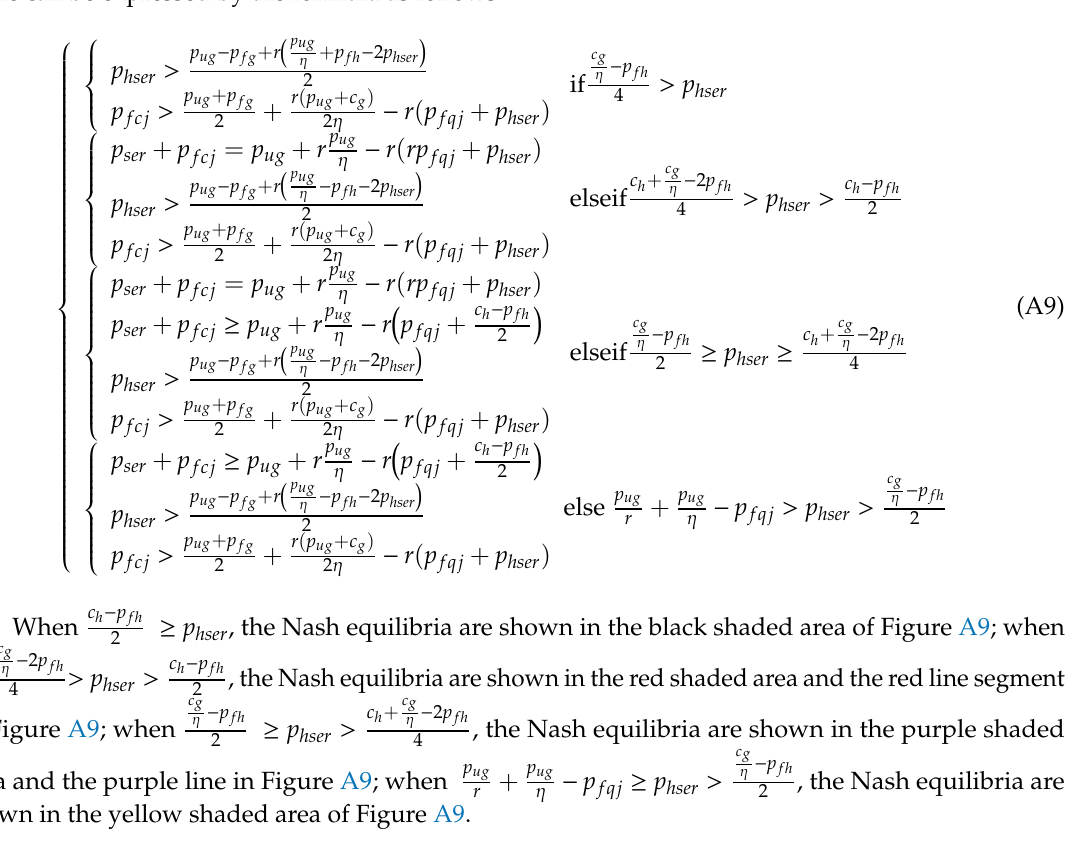
cg c g η + p fh > c > . When , the Nash equilibria of the tripartite 𝑐𝑔 η h P 2 +𝑝 𝑓ℎ 𝜂 , the Nash equilibria of the tripartite 2